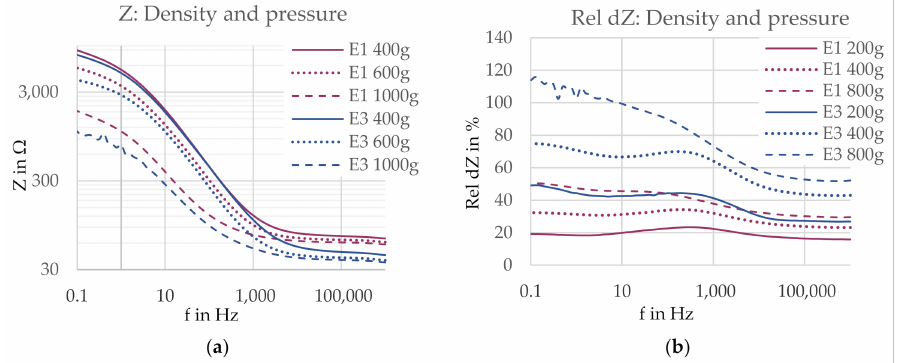
Figure 17. ( a ) Contact impedance Z and ( b ) impedance change rel dZ for electrodes with a lower yarn density (E1, 17.4 cm 2 , pink) and higher yarn density (E3, 19.0 cm 2 , blue). Electrode versions are marked with different colors, and pressure levels are marked with different line